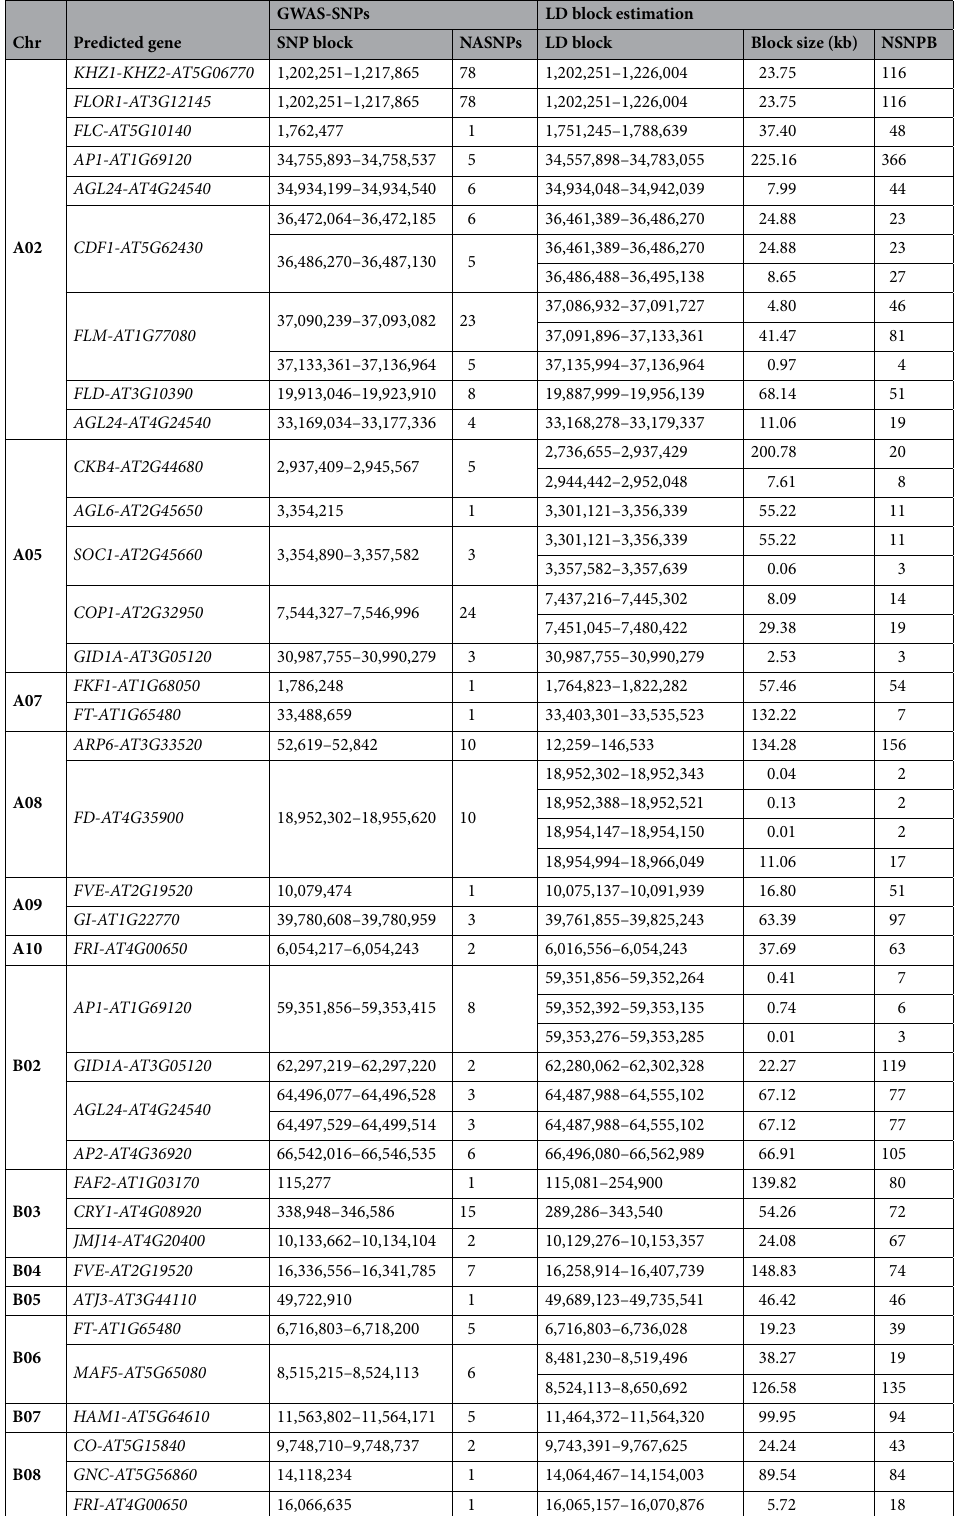
Table 3. LD block estimation for SNPs within 1 Mb regions of predicted genes associated with flowering and plant height traits. Chr chromosome, GWAS-SNPs significant SNPs identified in GWAS study, SNP block coordinates of identified significant SNPs in base pair, NASNPs number of associated SNPs, LD block estimated LD blocks for SNPs within 1 Mb region, block size (kb) distanced spanned by block in kb, NSNPB number of SNPs in LD